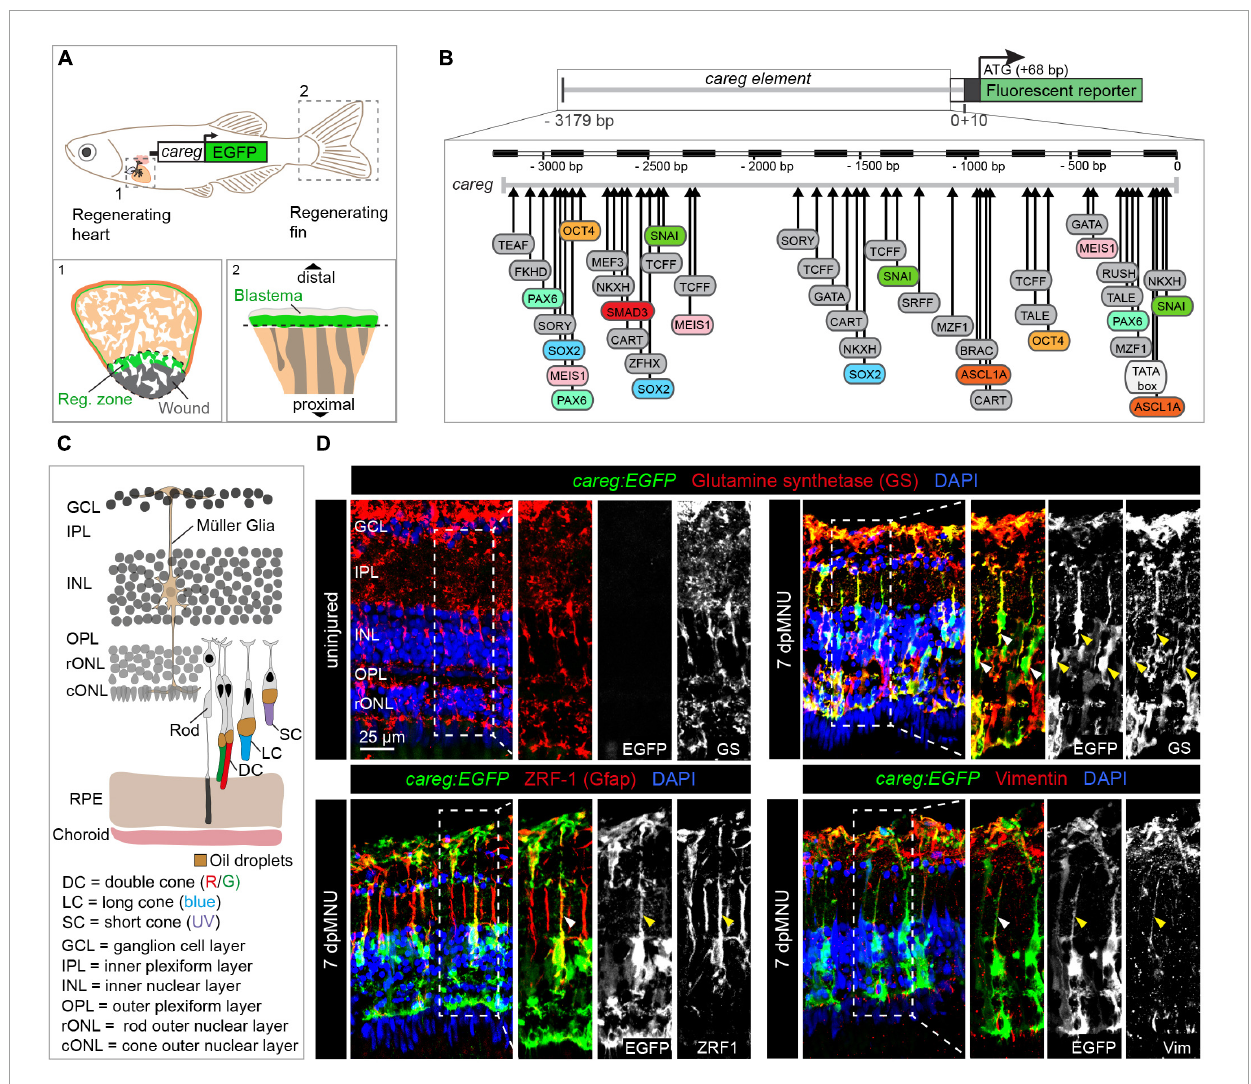
FIGURE1 The careg regulatory element is activated in Müller glia during retina regeneration. (A) Schematic representation of the transgenic zebrafish line carrying the careg regulatory element upstream of the EGFP reporter, based on Pfefferli and Ja´zwi´nska (2017). The careg:EGFP transgene is activated during heart (1) and fin (2) regeneration. (B) Prediction of transcription factor binding sites in the careg sequence with MatInspector (Genomatix) (Pfefferli and Ja´zwi´nska, 2017). (C) Schematic representation of the retina in adult zebrafish, with an illustration of photoreceptors, based on Raymond and Barthel (2004) and Lagman et al. (2015). Outer segments of cones are colored according to their spectral sensitivity. Abbreviations are listed on legend at the bottom of the drawing. (D) Immunofluorescence stained sections of uninjured and 7 days post-MNU treatment (dpMNU) retinas of careg:EGFP (green) transgenic fish using three Müller glia markers (red): glutamine synthetase (GS), vimentin and the glial fibrillary acidic protein (GFAP, visualized with ZRF-1 antibodies). Nuclei are stained with DAPI (blue). In uninjured retina, no careg:EGFP is detected. At 7 dpMNU, careg:EGFP partially overlaps with some cells expressing GS, GFAP, and vimentin (arrowheads). In this, and all subsequent figures, a dashed frame demarcates the magnified area shown in adjacent panels. N ≥ 3 (number of